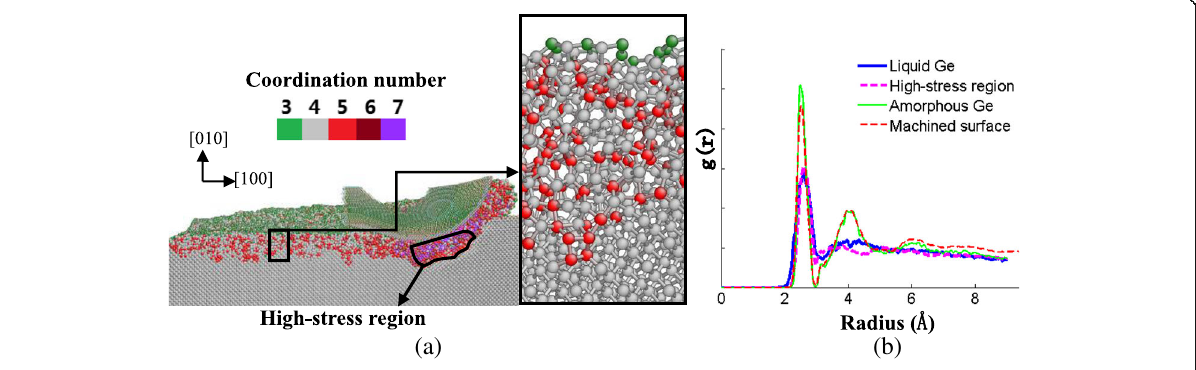
Fig. 5 a Atomic structure and coordination number distribution of machined surface of germanium, b RDF